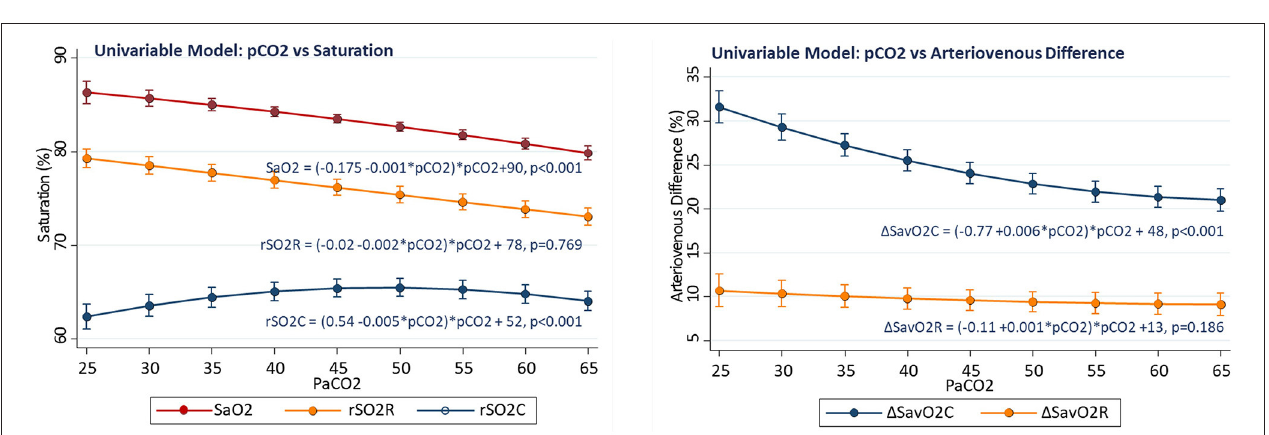
FIGURE 2 | Changes in regional oxygenation and with arterial PaCO2 in univariable